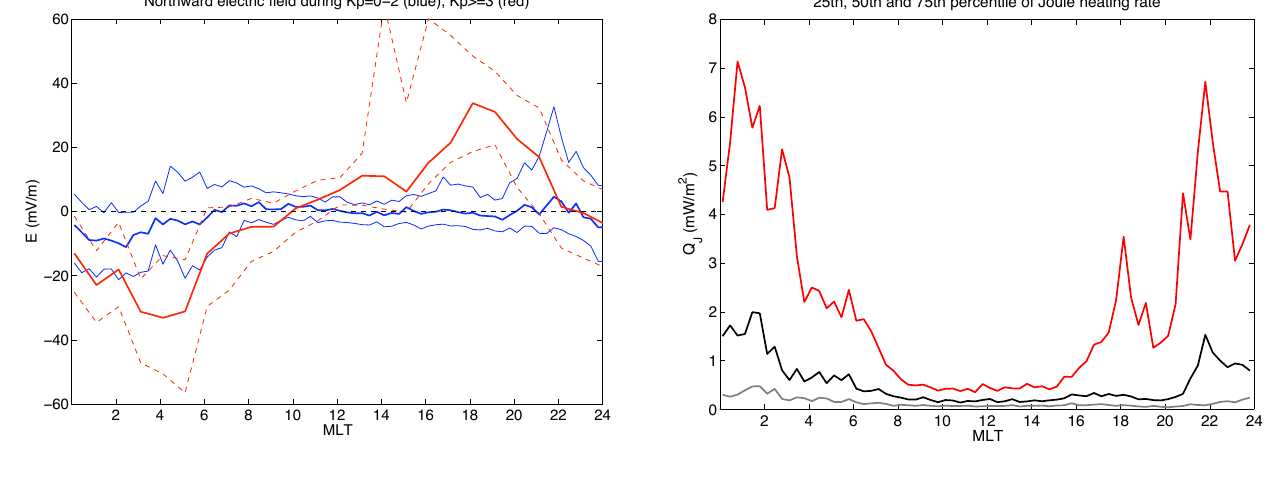
Fig. 11. Joule heating rate, same format as Fig. 3.